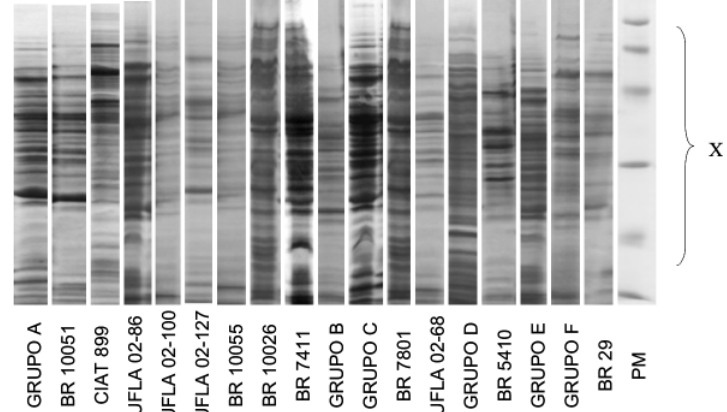
Figura 2. Perfis de proteína celular total de estirpes isoladas do solo da área em estudo, das estirpes de referência e das estirpes tipo obtidas por eletroforese em gel de poliacrilamida (SDS-PAGE). X = área utilizada – 15 bandas; PM = padrão de peso molecular